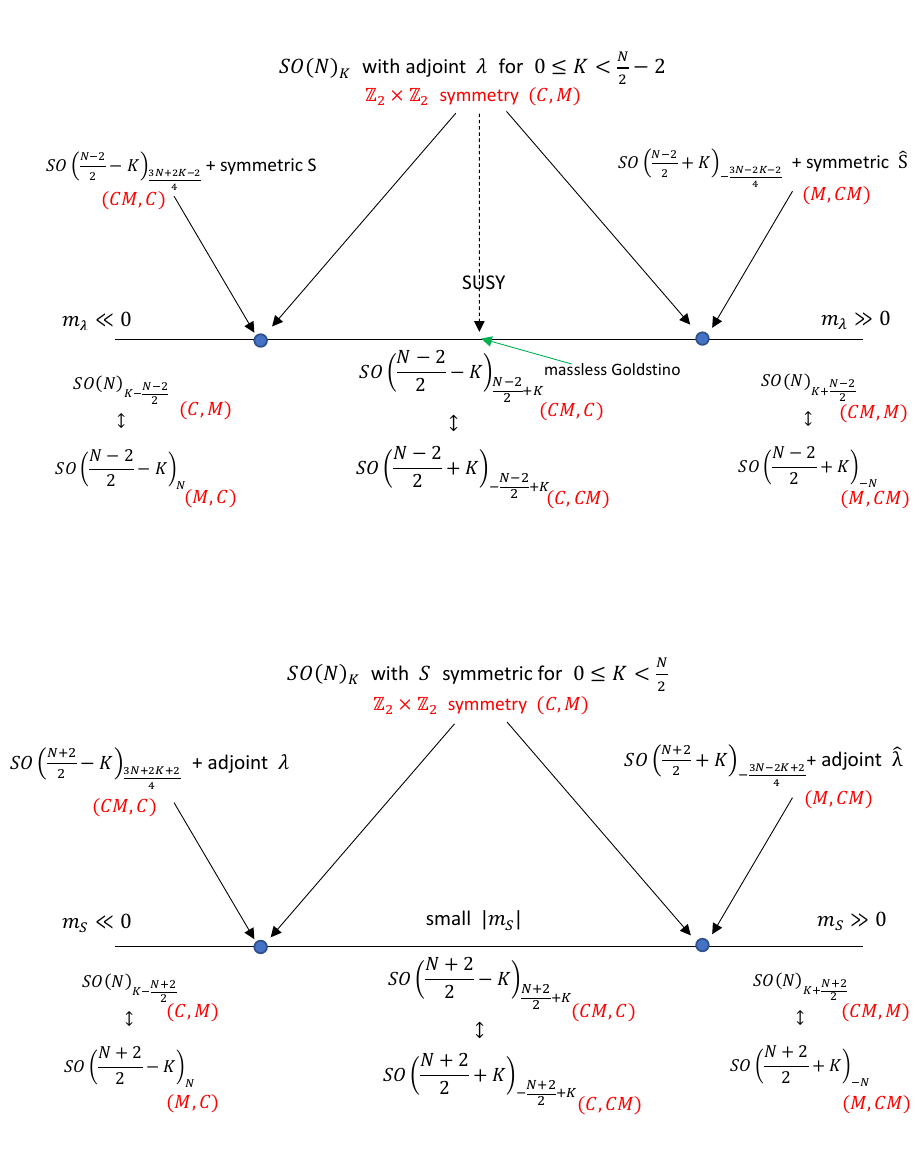
Figure 4: The phase diagrams of SO ( N ) gauge theory coupled tensor fermions. The infrared TQFTs, together with relevant level-rank duals are shown along the